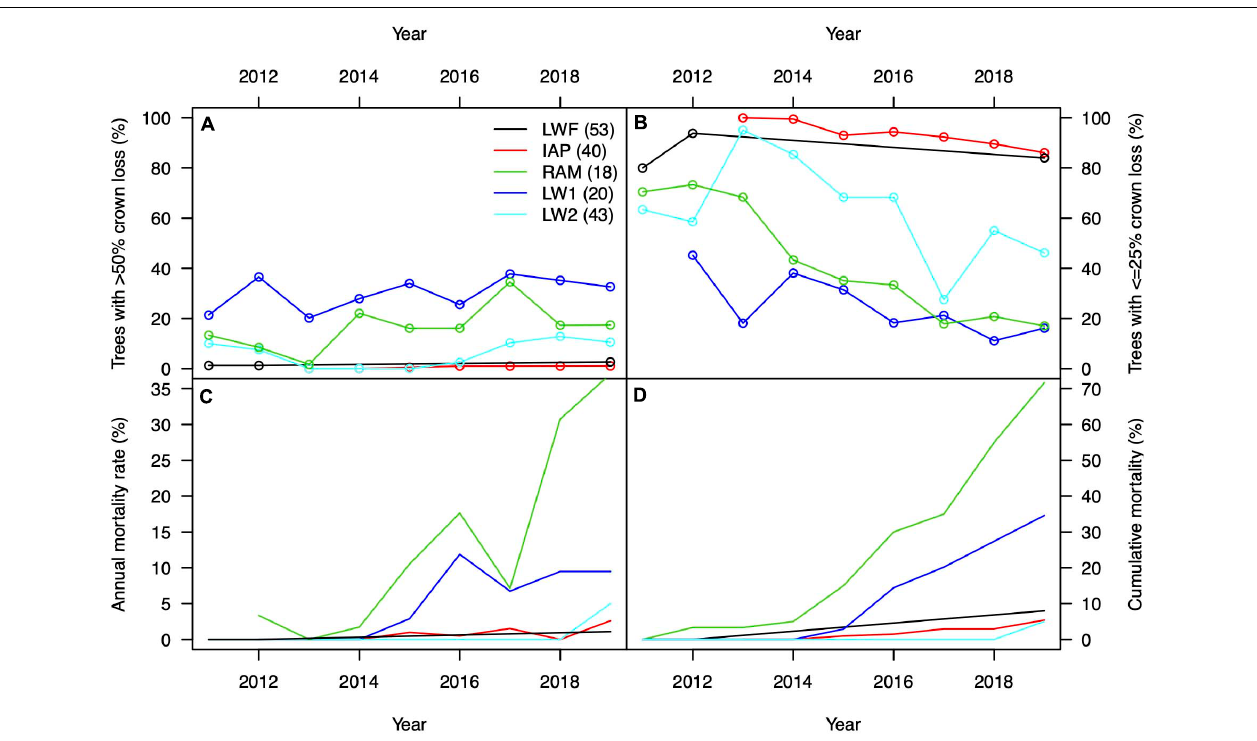
FIGURE 2 | (A) Observed percentage of ash trees with > 50% crown loss and (B) ≤ 25% crown loss in the targeted monitoring plots. Numbers in brackets denote the median DBH of monitored trees in the first year of the respective survey. Panel (C) shows annual mortality rate and (D) the cumulative mortality of the monitored trees. In panel (C) data from LWF was excluded, because the monitoring interval was not annual [see circles in panel (A) for actual years of survey]. RAM, LW1, and LW2 are the monitoring plots of the WSL